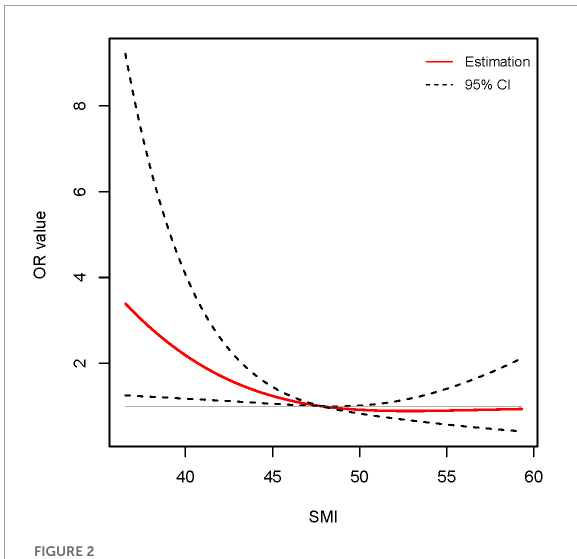
FIGURE2 Association between skeletal muscle mass index (SMI) level and long-term (1-year) incidence of cirrhosis using restricted cubic spline (RCS) analysis ( P for non-linear = 0.127). Results were corrected with age, international normalized ratio (INR), total bilirubin (TB), and serum sodium.